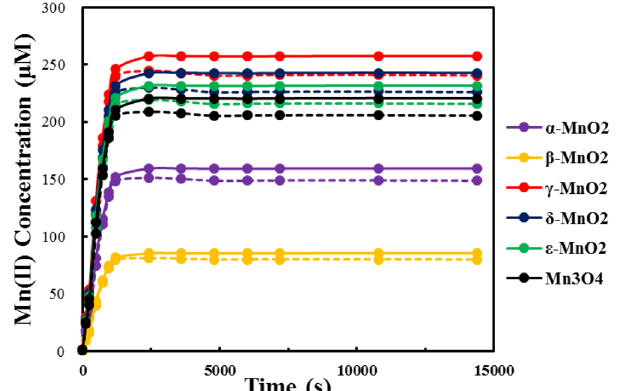
Figure 4. The release of Mn(II) in the laccase-mimicking reactions of ABTS (2 mM) oxidation by MnO x (333.6 μ M) at pH 6.0 in systems with O 2 saturated (21.5 mg/L, dash line) or depleted (0.30 mg/L, solid